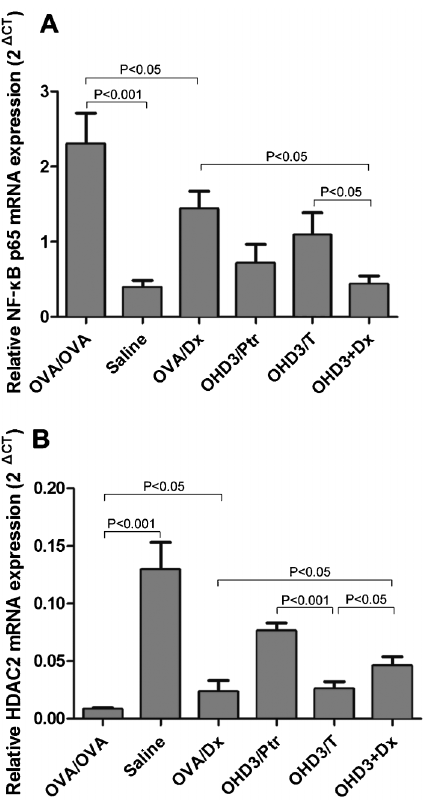
Figure 4. Effects of different treatments on NF- k B p65 and HDAC2 gene transcription in the lung. Bars represent mean±SD (n=5/group). The relative ratio of mRNA of NF- k B p65 to that of GAPDH was significantly higher in the OVA/OVA group than in the control group (P , 0.001, A ). 1,25(OH) 2 D 3 pretreatment, treatment and the combined treatment significantly decreased NF- k B p65 mRNA expression in the OVA sensitized and challenged rats (P , 0.001). The NF- k B p65 mRNA level in OHD3++Dx was also lower than that in the OVA/Dx and OHD3/T groups (P , 0.05). In contrast, the relative ratio of mRNA of HDAC2 to that of GAPDH was significantly lower in the OVA/OVA group than in the control group (P , 0.001). 1,25(OH) 2 D 3 pretreatment, treatment and the combined treatment significantly increased the expression level of HDAC2 mRNA in the OVA sensitized and challenged rats (P , 0.001). The HDAC2 mRNA level was higher in the OHD3/Ptr group than in the OHD3/T group (P , 0.001). The HDAC2 mRNA level in the OHD3++Dx group was also higher than that in the OVA/Dx and OHD3/T groups (P , 0.05). ANOVA and Student-Newman-Keuls tests were used for statistical analyses. Saline: control group; OVA/OVA: asthma group; OVA/Dx: dexamethasone treated group; OHD3/Ptr: 1,25(OH)